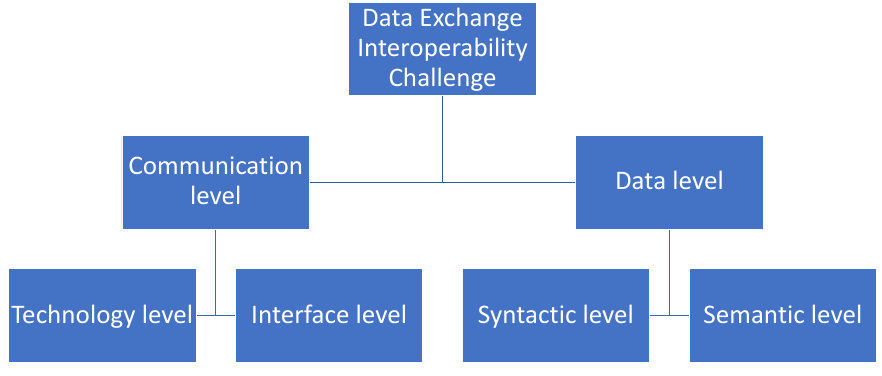
Figure 1. Data exchange interoperability challenge.